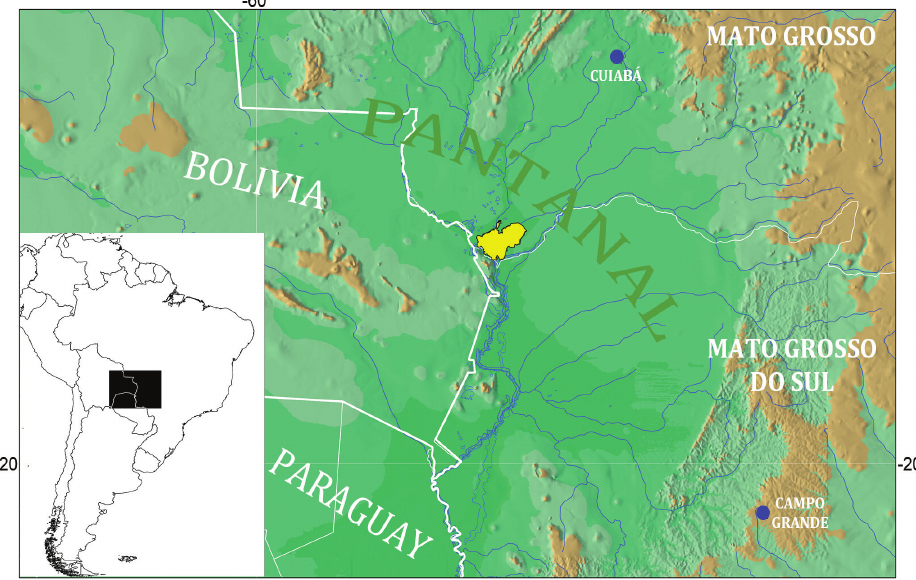
Fig. 1. Map of study area locating the Pantanal National Park in the centered or lighter spot (17°50’46.60”S, 57°24’10.40”W) of the Upper Paraguay River basin,